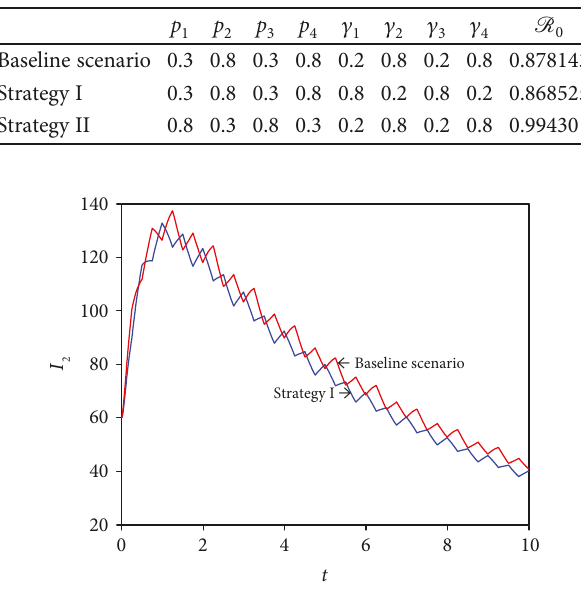
Figure 4: Time series plot of the total of infected trees for the baseline scenario and Strategy I.